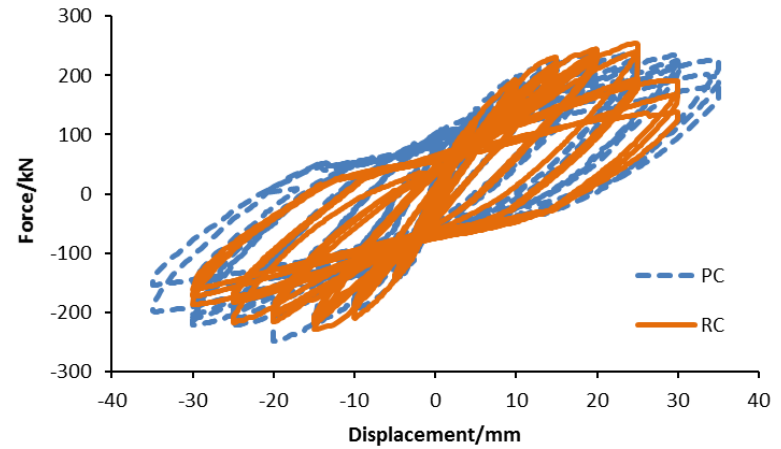
Figure 10. Hysteretic curves.